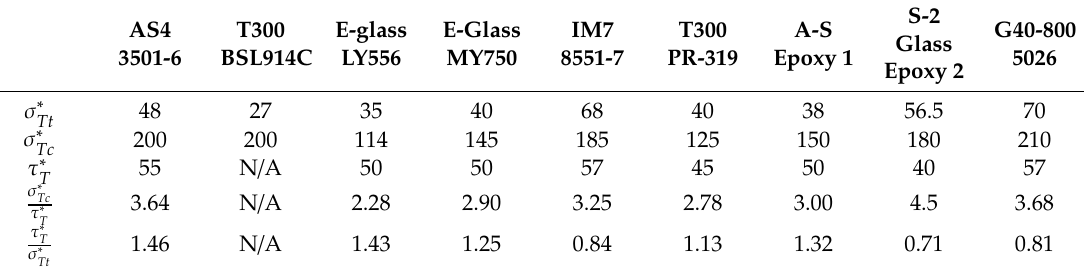
Table 1. Transverse strengths (MPa) of a range of